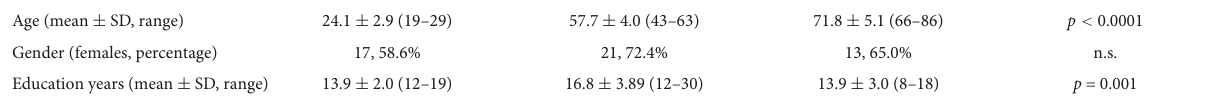
TABLE 1 Demographic